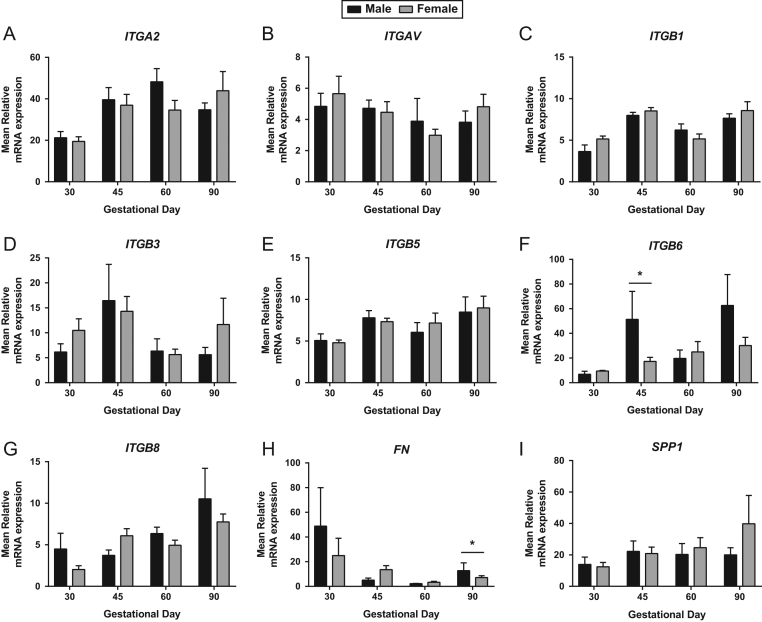
Integrin mRNA expression in placental tissues associated with male and female foetuses on days 30, 45, 60 and 90 of pregnancy. mRNA expression of ITGA2 (A), ITGAV (B), ITGB1 (C), ITGB3 (D), ITGB5 (E), ITGB6 (F), ITGB8 (G), FN (H) and SPP1 (I) in placental samples associated with male and female foetuses at GD30, 45, 60 and 90. Error bars represent s.e.m. *P ≤ 0.05. n = 4–12 foetuses/GD.